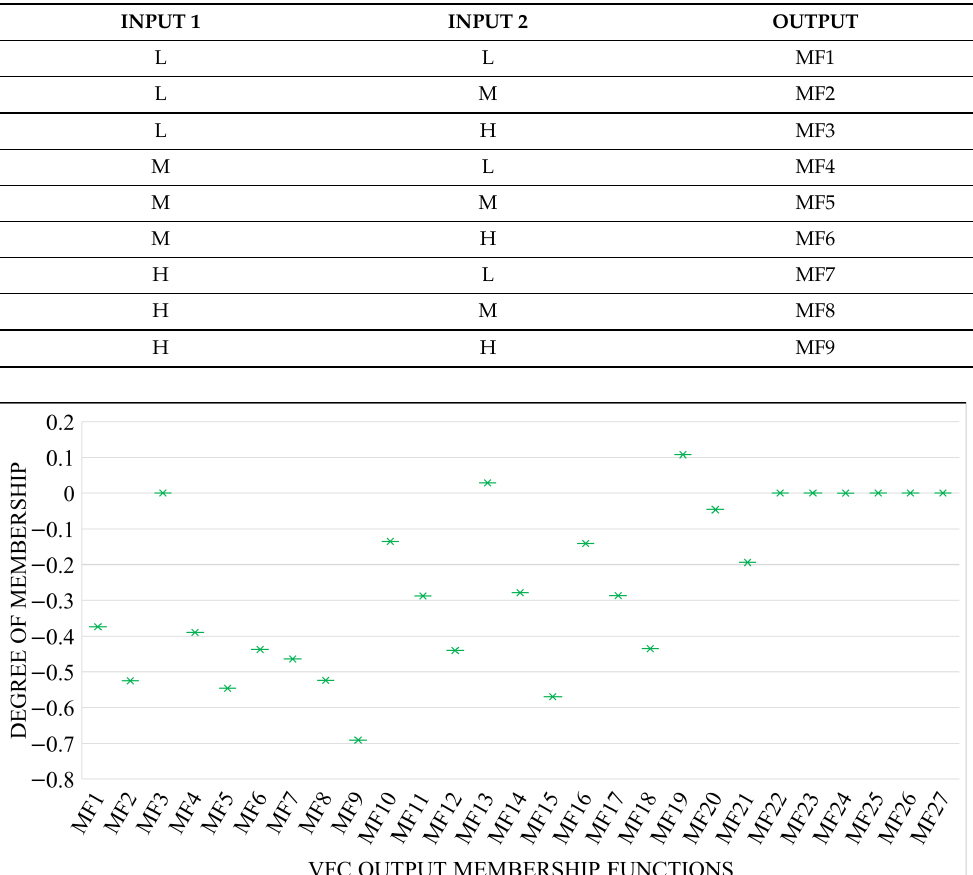
Table 6. Tuned fuzzy rules of inertia controller.